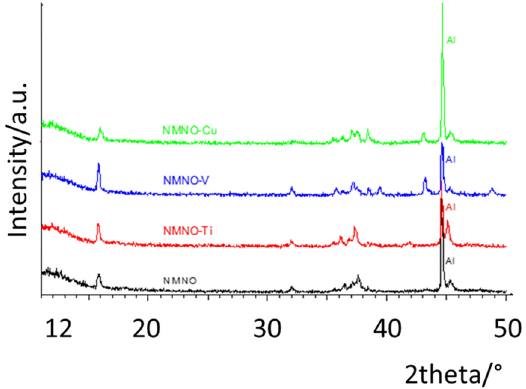
Figure 9. Ex-situ XRPD patterns collected after charge–discharge measurements for all the sam- ples.